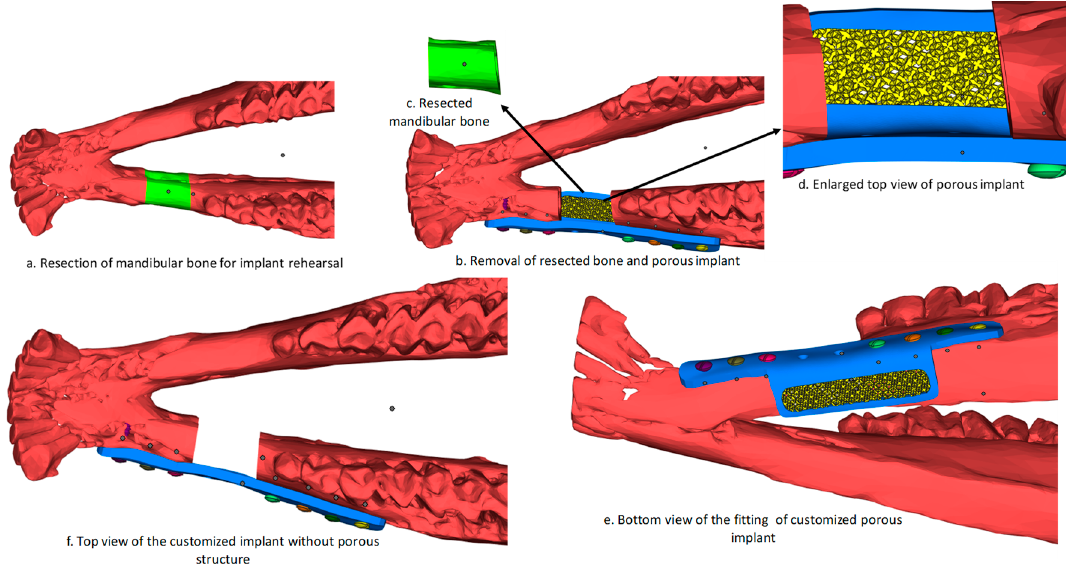
Figure 3. Virtual representation of mandibular bone resection and fitting of customized mandibular plates.